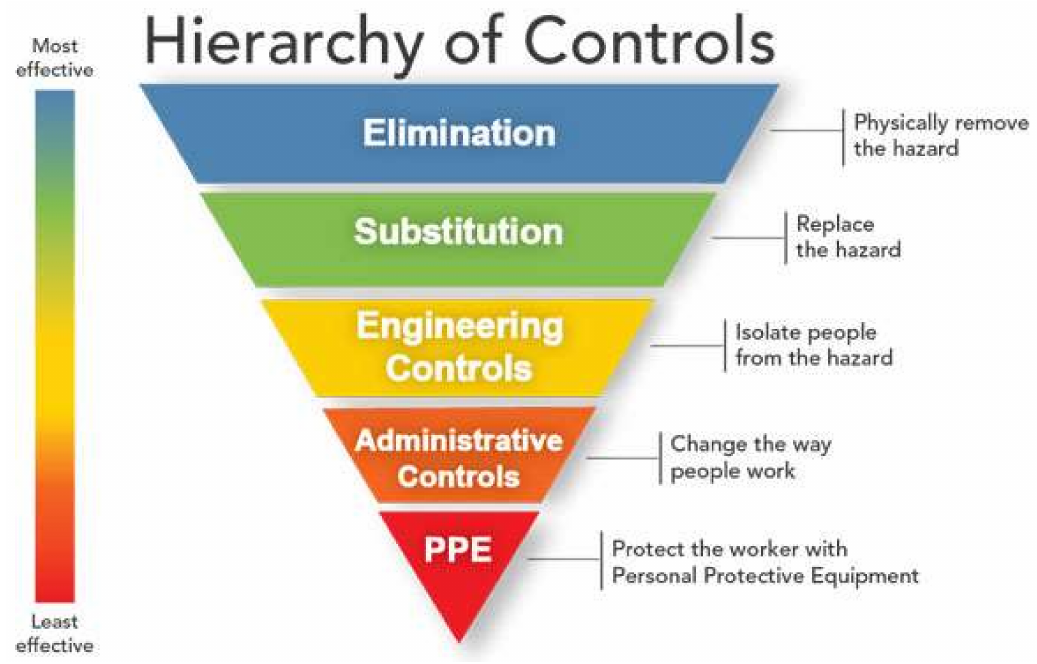
Figure 1. NIOSH model of HOC